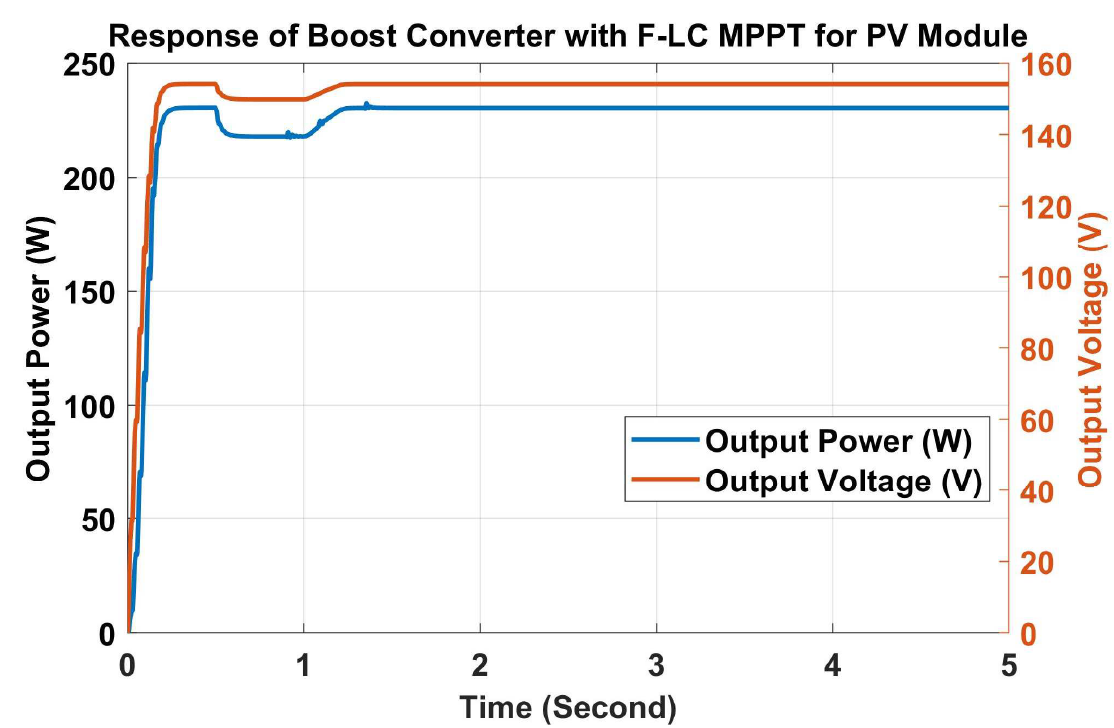
Figure 18. Output Power and Voltage of Boost Converter with F-LC MPPT for PV Module.